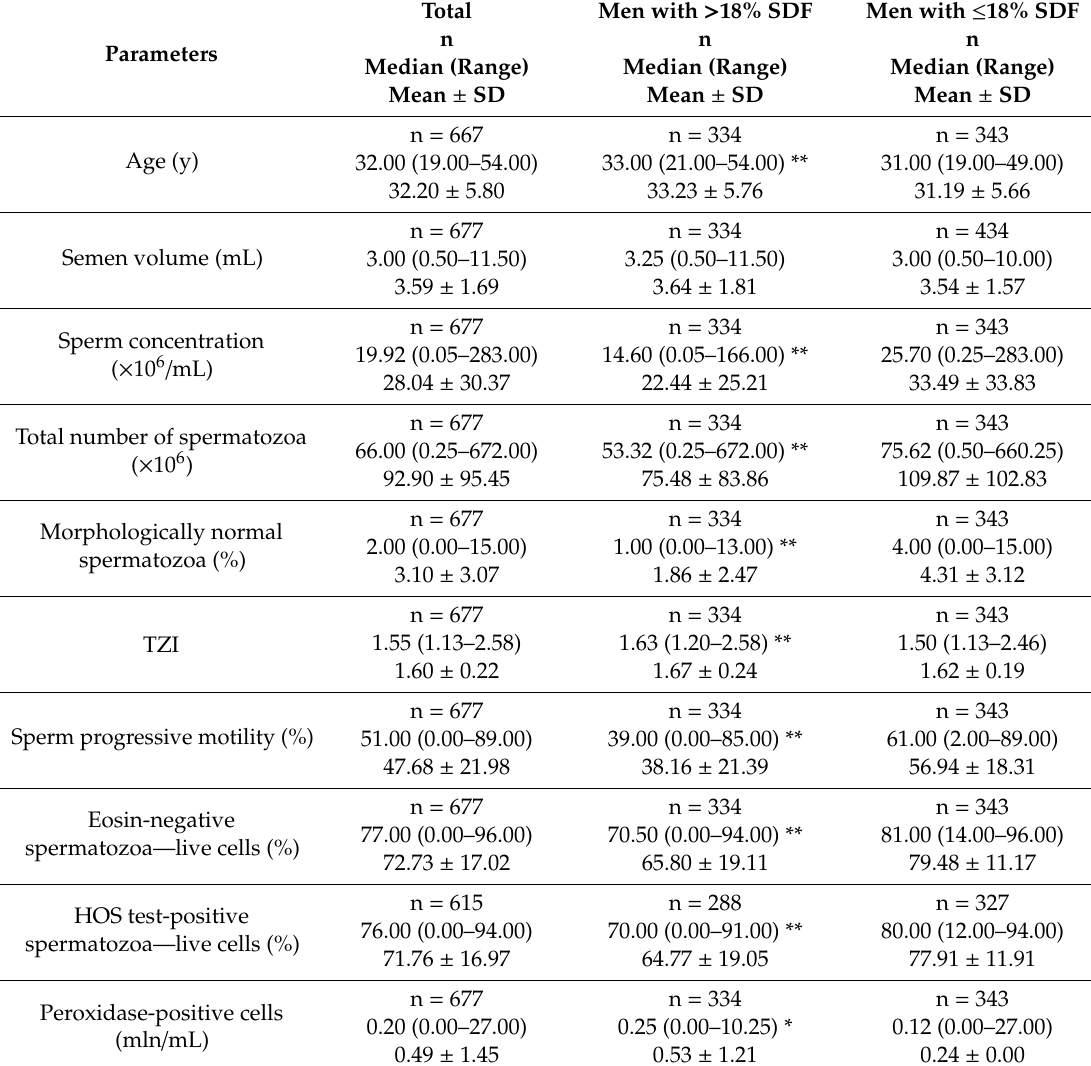
Table 1. Descriptive statistics and comparison of age and standard semen parameters in men with > 18% SDF and men with ≤ 18%